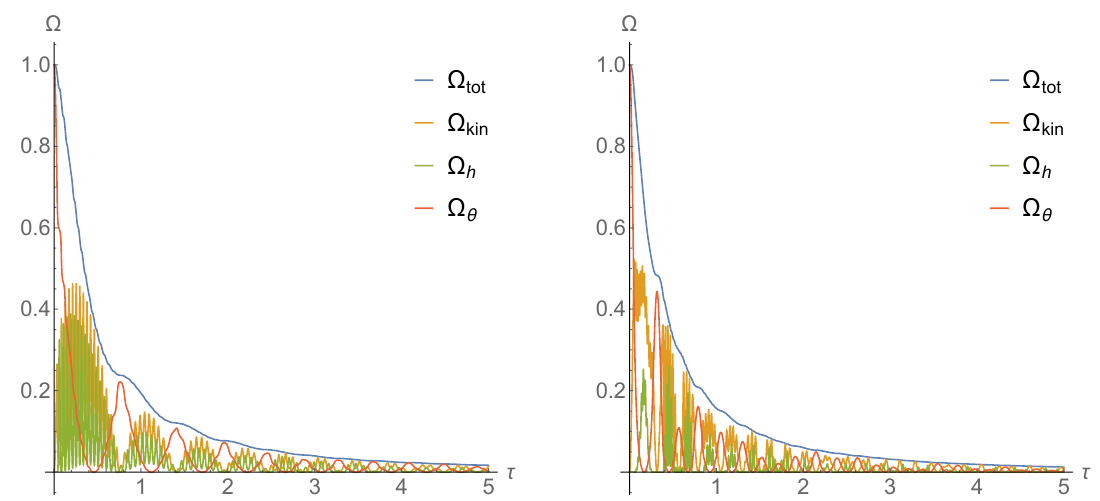
Figure 4 . The evolution of the density fraction (cid:10) i = (cid:26) i = (cid:3) 4 decoupling case with h 0 = (cid:3) = 0 : 08. Left-panel: the evolution based on (3.8) and (3.9). Right-panel: the evolution based on (3.12) and (3.13) with the presence of a portal coupling g s h 2 (cid:30) 2 = 2.